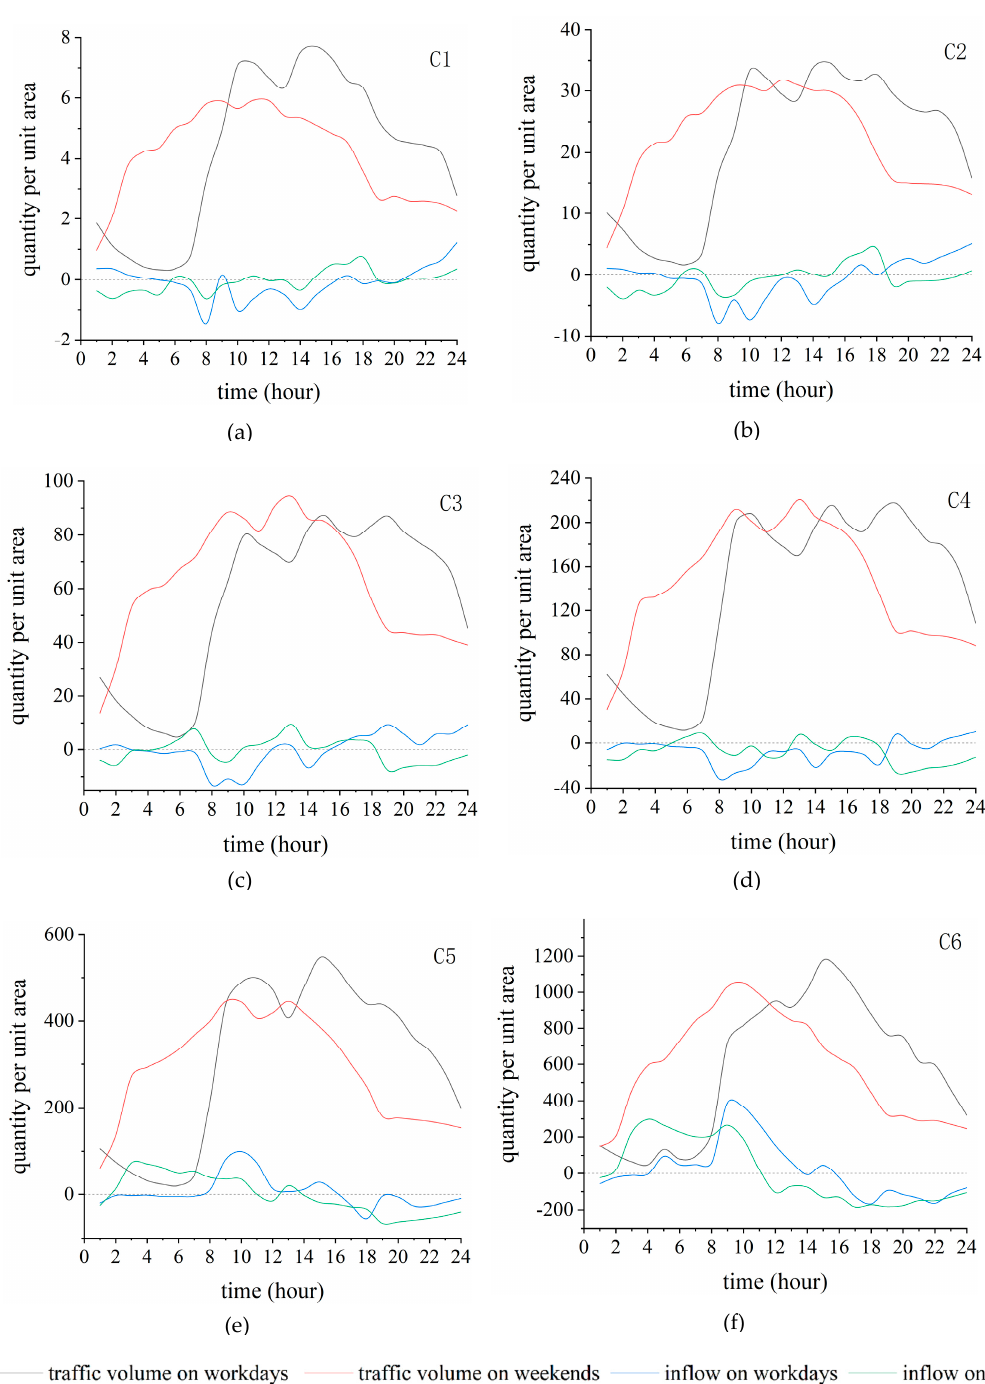
Figure 9. Characteristics of resident trips in different clusters. (a) tTraffic volume/inflow quantity on workdays/weekends per square kilometre in Cluster 1. (b) Traffic volume/inflow quantity on workdays/weekends per square kilometre in Cluster 2. (c) Traffic volume/inflow quantity on workdays/weekends per square kilometre in Cluster 3. (d) Traffic volume/inflow quantity on workdays/weekends per square kilometre in Cluster 4. (e) Traffic volume/inflow quantity on workdays/weekends per square kilometre in Cluster 5. (f) Traffic volume/inflow quantity on workdays/weekends per square kilometre in Cluster 6.